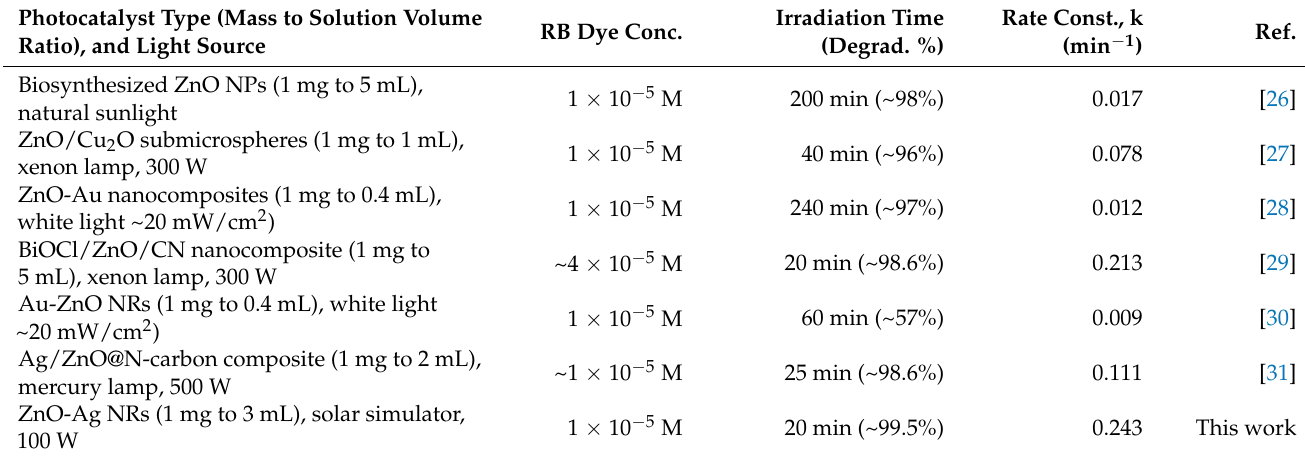
Table 1. Comparison of ZnO-based catalysts for RB dye photodegradation.